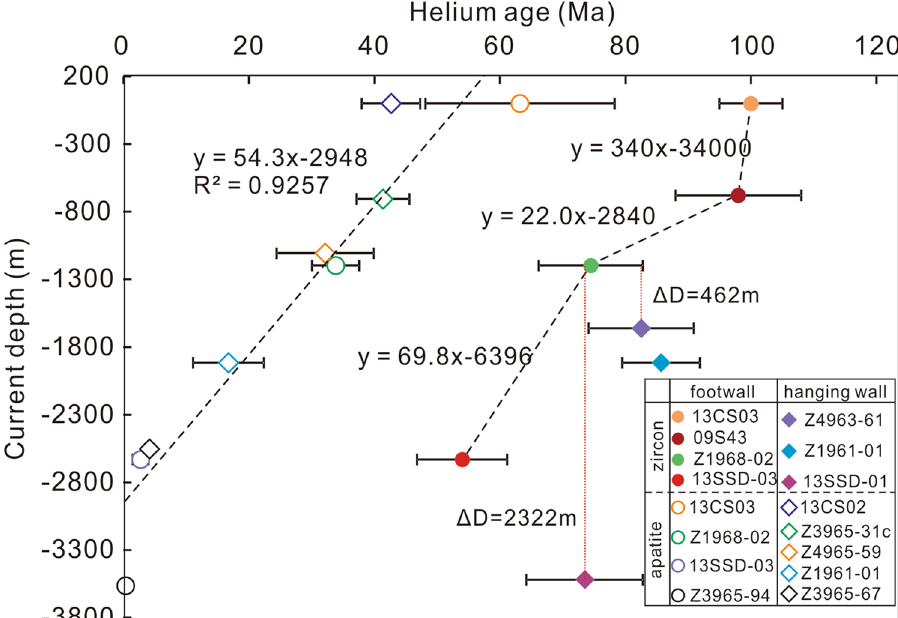
Figure 6. A plot of ZHe and AHe ages versus depth for rock samples from the footwall and hang wall of the Sanshandao Au deposit. The ZHe ages are weighted mean ages and 2 σ errors from Table 3 after discarding the outliers, and the youngest value of 54 Ma was used due to influence of inclusions. The AHe ages are the youngest single age from each sample and the errors are 2 σ . Note ZHe ages from hanging wall are older than those from similar depth of footwall; while AHe ages are indistinguishable for hanging wall and footwall, and form a good linear array. See the text for detailed